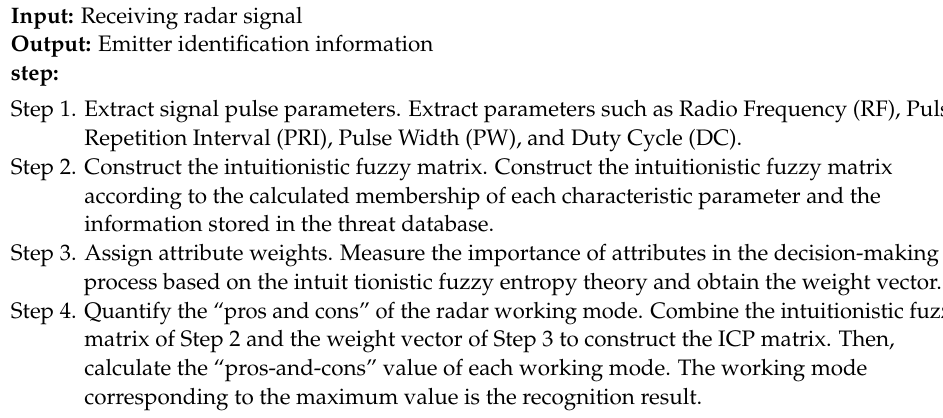
Algorithm 1: IFS Radar Working Pattern Recognition